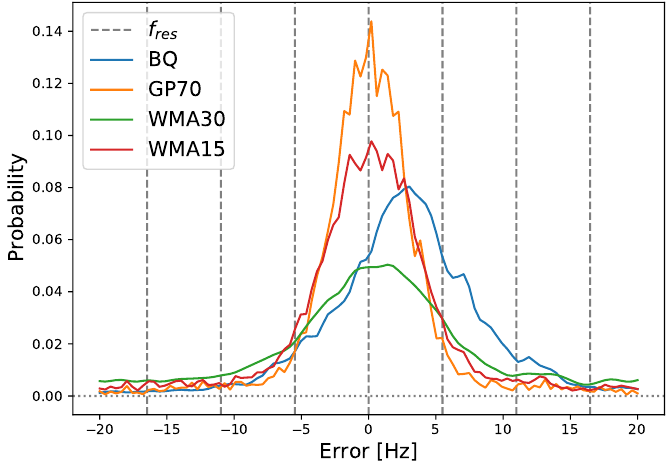
Figure 3. Probability density plot of the errors obtained by non-ML algorithms. The errors are the difference of the respective tune estimates and the ground-truth resonance of he simulated data. BQ is the algorithm used until the LHC Run 2; GP70 uses Gaussian Processes with a Radial Basis Function kernel having a length scale of 70; WMA30 and WMA15 use a weighted moving average with a half-window length of 30 and 15, respectively. GP and WMA were introduced in